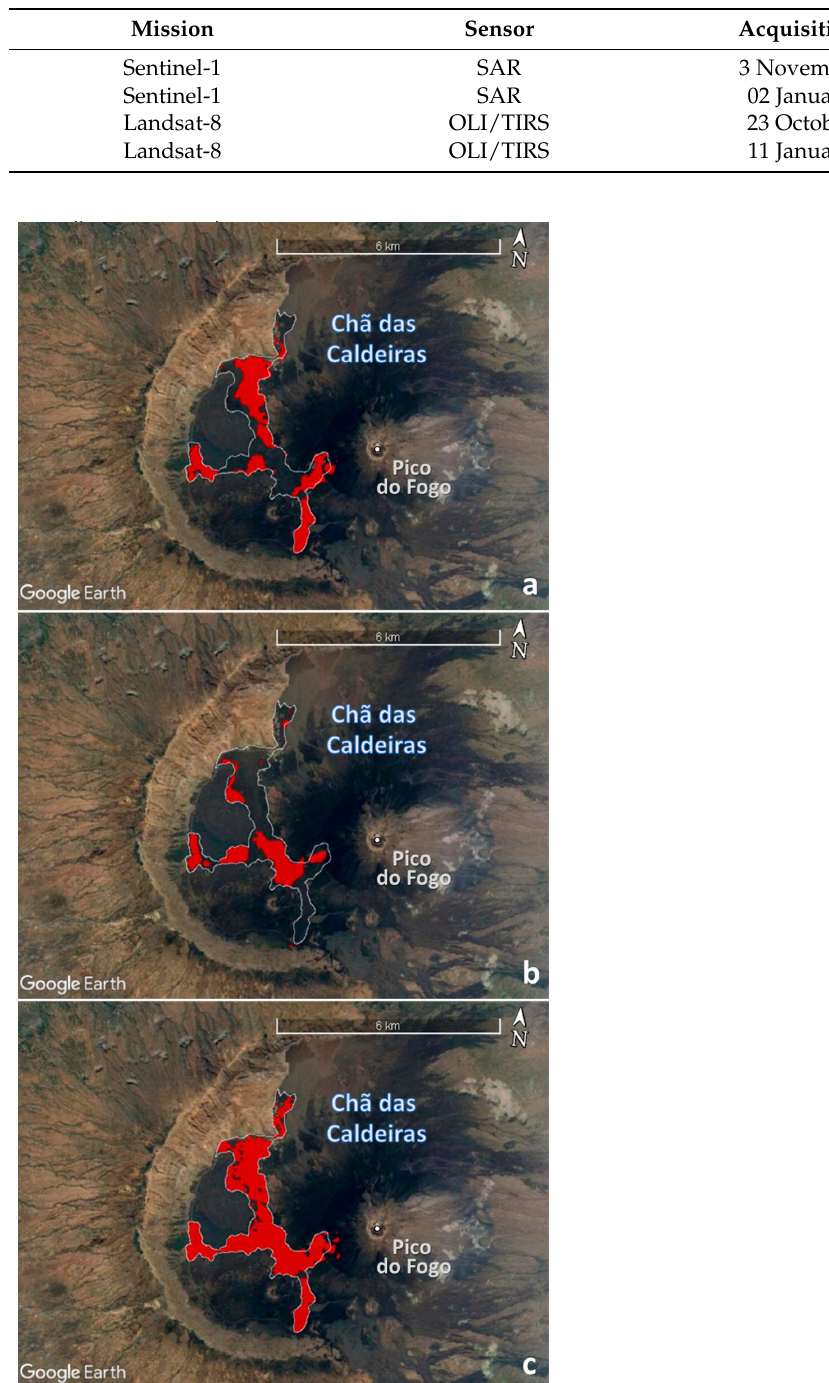
Table 4. Satellite dataset used for the 2014–2015 Fogo eruption.